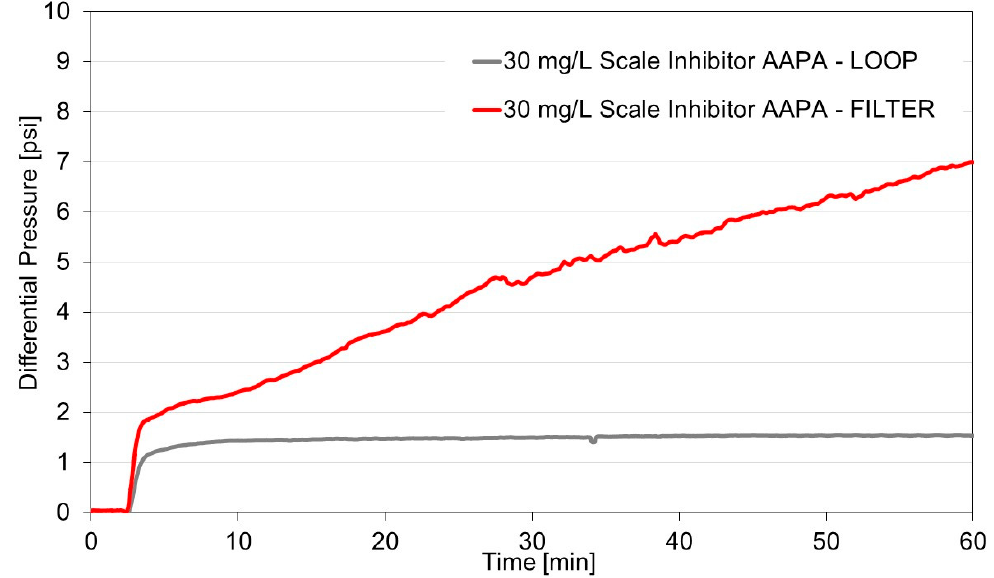
Figure 4. Carbonate precipitation in the filter (FILTER) and scaling coil (LOOP) dynamic systems at 80 °C and 44 psi, Inhibitor AAPA (30 mg/L).